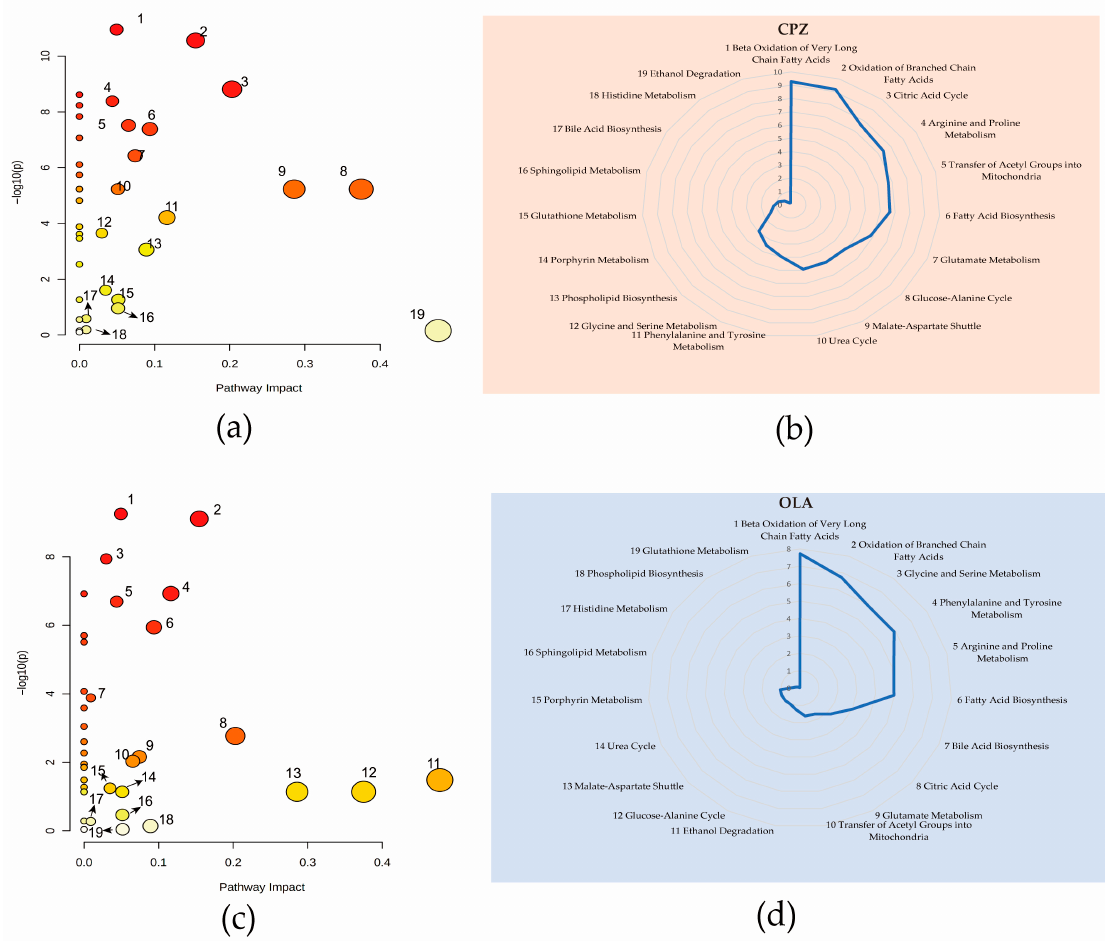
Figure 2. QEA results of fatal-intoxication models due to CPZ ( a , b ) and OLA ( c , d ) at high dose. Nineteen metabolic pathways with a PI score >0 in the CPZ animal model ( a ) and their associated logarithmic-transformed p -values ( b ). Nineteen metabolic pathways with a PI score >0 in the OLA animal model ( c ) and their associated logarithmic-transformed p -values ( d ). n = 10. Notes: Pathways represented by bubbles in a and c with a PI score >0 are listed by numbers according to their p (log- p ) values. Radar charts were utilized to show the names of metabolic pathways, and their significance is marked with the same numbers as those in bubble plots. Arrows in bubble plots are used to reduce the crowding of numeric markers.